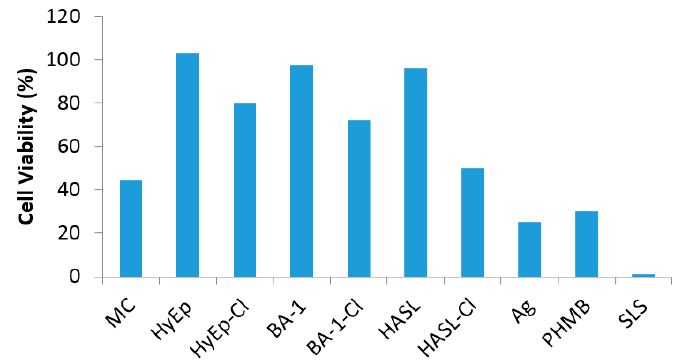
Figure 3. Cell viability analysis (MTT assay) on mouse fibroblast (NIH-3T3) of N-halamine precursor-coated and N-halamine-coated, and commercial silver alginate (Ag) and polybiguanide (PHMB) wound dressing test